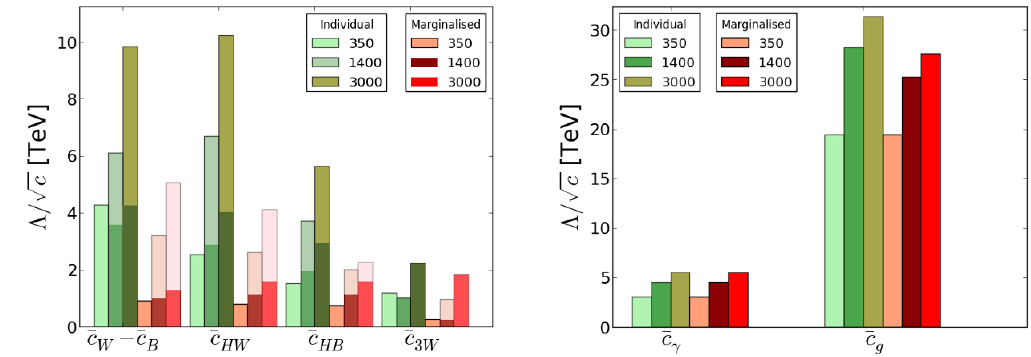
Figure 5 . The estimated sensitivities of CLIC measurements at 350 GeV, 1.4 TeV and 3.0 TeV to the scales of various (combinations of) dimension-6 operator coe(cid:14)cients: (cid:22) c W (cid:0) (cid:22) c B ; (cid:22) c HW ; (cid:22) c HB and (cid:22) c 3 W (left panel) and (cid:22) c (cid:13) and (cid:22) c g (right panel). The results of individual (marginalised) (cid:12)ts are shown as green (red) bars. The lighter (darker) green bars in the left panel include (omit) the prospective HZ Higgsstrahlung constraint. The darker red shades are marginalised results at each energy separately, while the lighter shades are for 350 GeV combined with 1.4 TeV (and 3 TeV) for the second (third) red